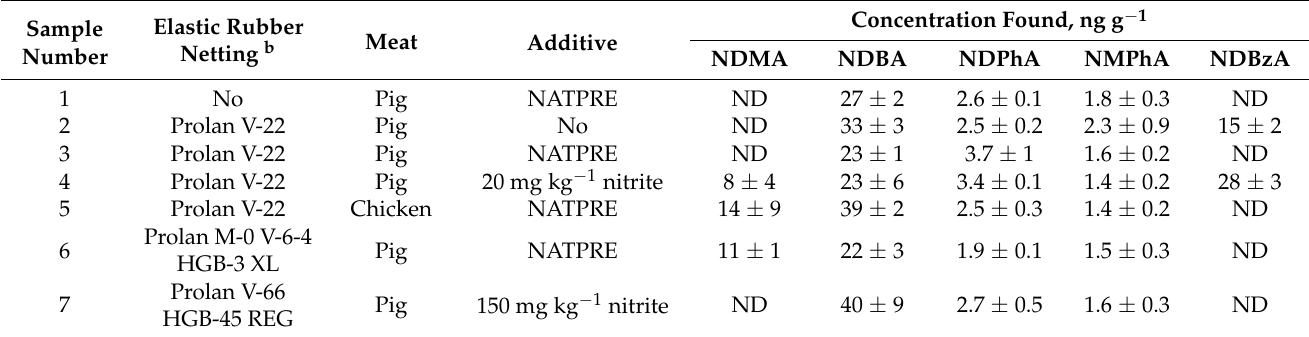
Table 4. Average concentration a found (ng g − 1 ) in cooked ham